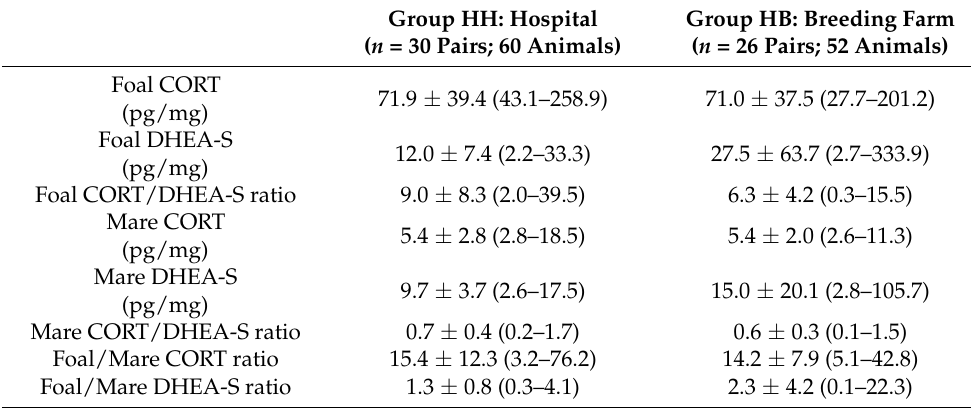
Figure 3. Frequency distribution graphs representing the ratio between foal CORT/DHEA-S ratio and mare CORT/DHEA-S ratio of the two groups (healthy foals—H, left; sick foals—S, right). In study 2, CORT and DHEA-S concentrations in foals and mares and their resulting ratios of HH and HB groups are shown in Table 3; no significant differences were found. Table 3. Results of study 2 in group Healthy (H) based on housing location at foaling (hospital— group, HH vs. breeding farm—group, HB). Data are expressed as mean ± standard deviation